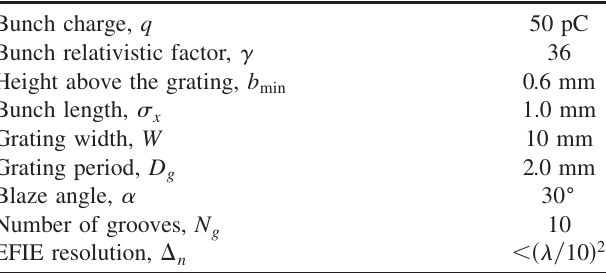
TABLE I. Smith-Purcell radiation parameters.